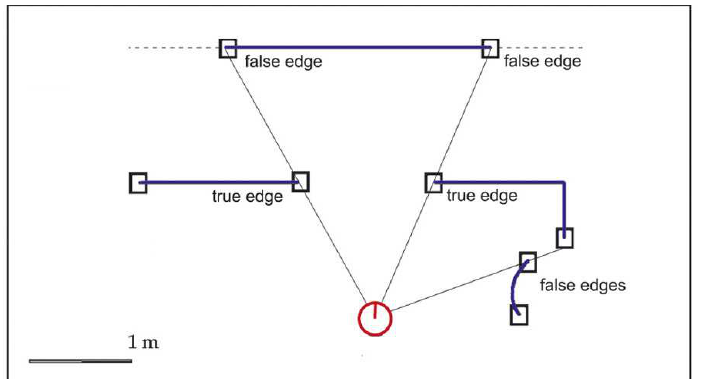
Figure 7. An edge is defined as a breakpoint associated to the end-point of a plane surface which is not occluded by any other